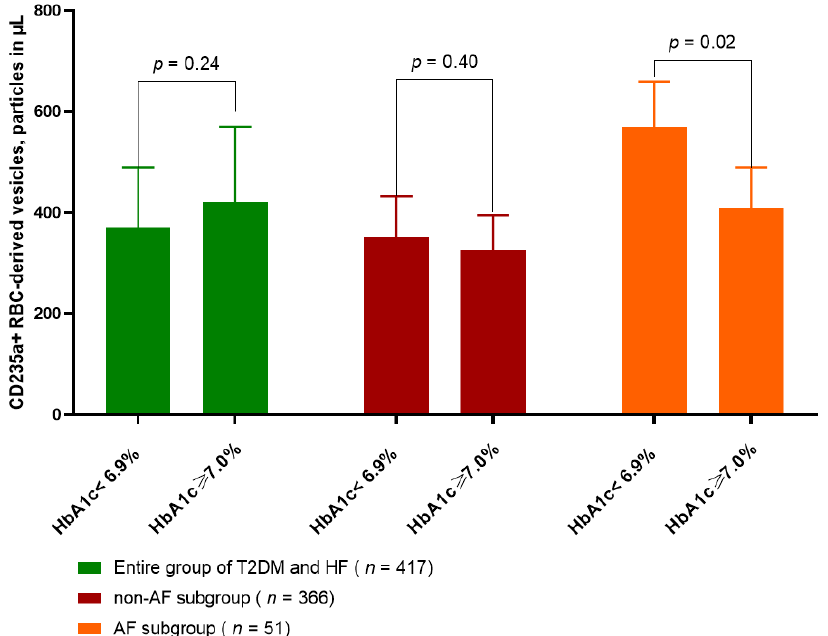
Figure 2. The amount of CD235a+ PS+ RBC-derived vesicles in T2DM patients with HF depending of glycemia control. Abbreviations: T2DM, type 2 diabetes mellitus; HF, heart failure; AF, atrial fibrillation, RBC, red blood cells; PS, phosphatidylserine; HbA1c, glycosilated hemoglobin.